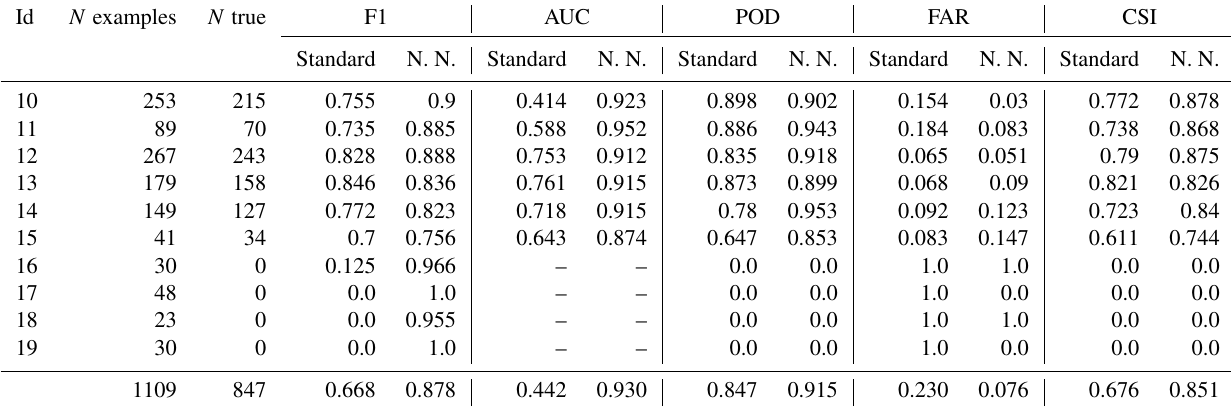
Table 4. Table of metrics for the standard method and the N SH = 1000 neural network model (denoted N. N.) computed using the test set of manually labeled HOLODEC holograms. The number of examples equals the total number predicted by both the standard method and the neural network, while the true number was determined by manual examination. The confidence scores assigned to the manual labels by the reviewers were used in the AUC